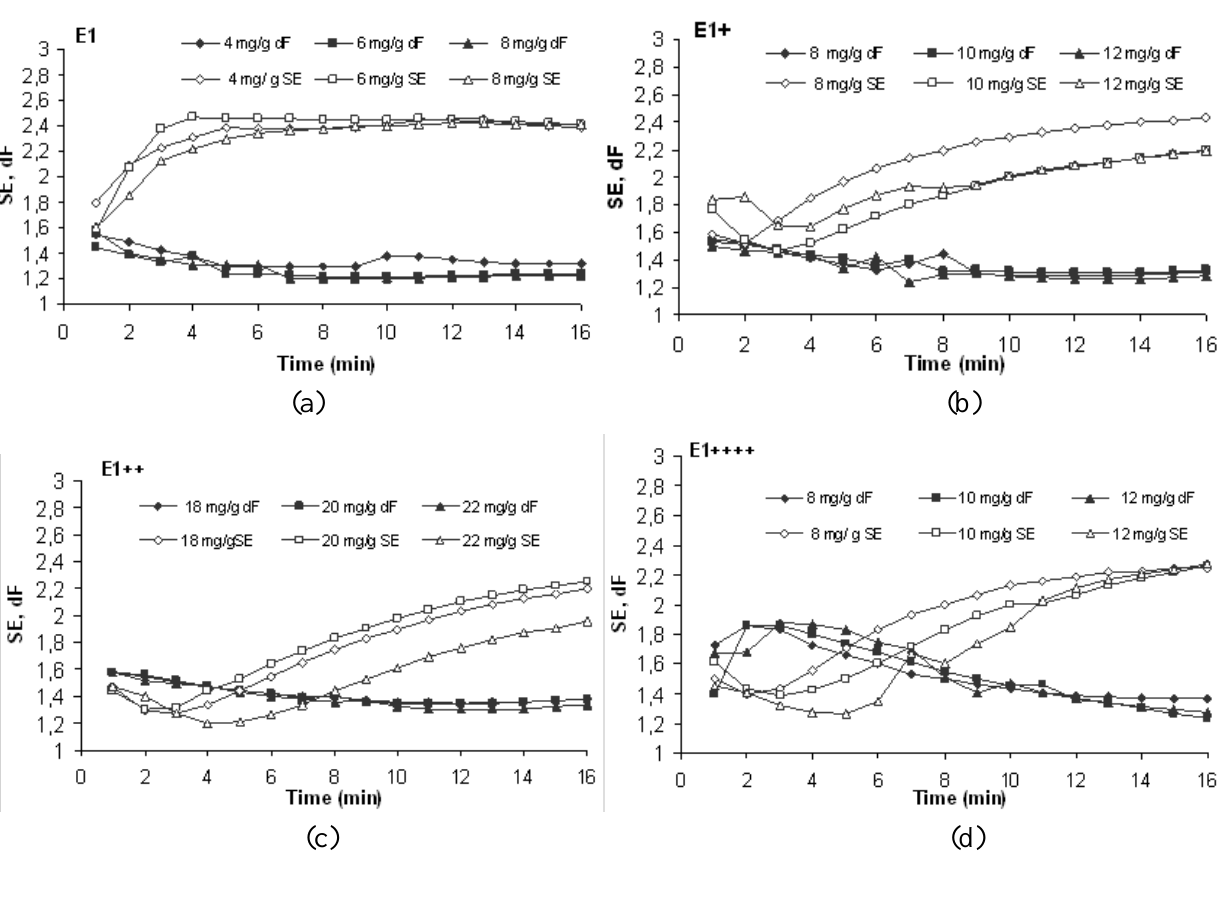
and SE) for PELs E1, E1+, E1++ and F